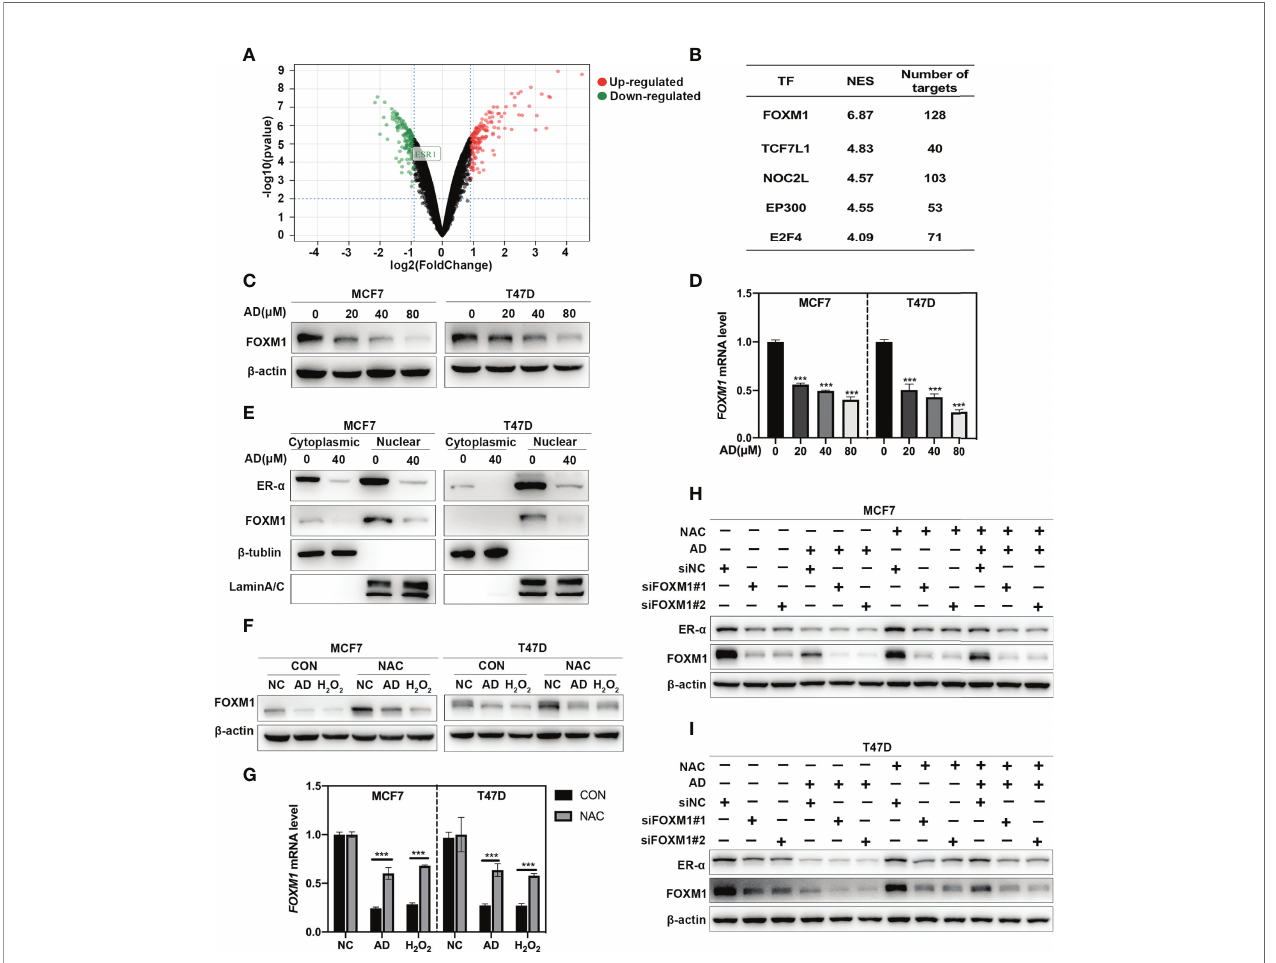
FIGURE 4 | AD suppresses ESR1 transcription via ROS-FOXM1 axis. (A) Volcano plot showing the DEGs between the control and H 2 O 2 treatment group from the GSE10061 dataset. ESR1 belonging to the down-regulated genes was highlighted. (B) The top fi ve predicted transcription factors regulating the DEGs were listed. (C) Cells were treated with 1 ‰ DMSO or the indicated concentrations of AD for 24 h. Cell protein was extracted and detected by Western blotting with antibodies against FOXM1 and b -actin. (D) The mRNA level of FOXM1 was quanti fi ed by RT-PCR (normalized to b -actin). (E) MCF7 and T47D cells were treated with 1 ‰ DMSO or AD (40 m M) for 24 h. Cytoplasmic and nuclear protein extracts were collected as described in the Materials and Methods section and subjected to Western blotting with antibodies against ER- a , FOXM1, b -tublin and LaminA/C. (F) NAC attenuated AD-inhibited the expression of FOXM1. MCF7 and T47D cells were treated with AD (40 m M) and/or NAC (5 mM) for 24 h and subjected to Western blotting for the expression of FOXM1. (G) The mRNA level of FOXM1 was quanti fi ed by RT-PCR (normalized to b -actin). H 2 O 2 was used as a positive control. (H, I) MCF7 and T47D cells were transfected with control or FOXM1 siRNA for 48 h, then treated with AD (40 m M) and/or NAC (5 mM) for 24h and subjected to Western blotting for the expression of FOXM1 and ER- a . (Data were presented as mean ± SD. *** P <